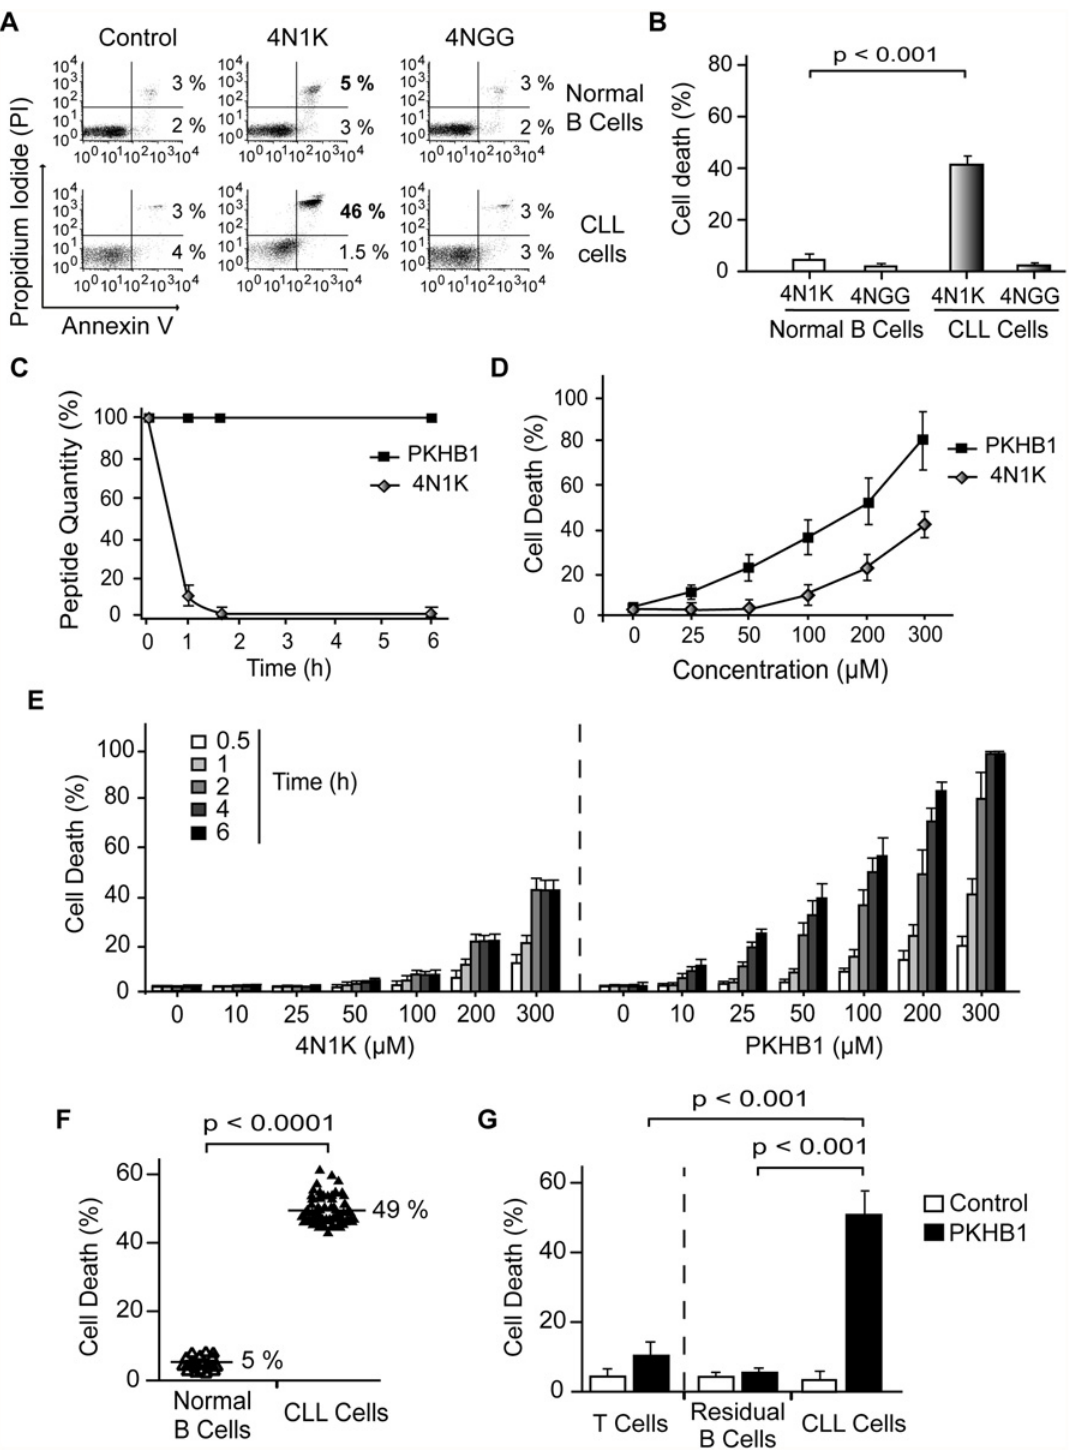
Fig 1. PKHB1 selectively induces cell death in leukemic B cells, including those from patients with dysfunctional TP53 . (A) Cell viability measured by Annexin-V and PI staining in normal or CLL B lymphocytes treated with 4N1K (300 μ M, 2 h) or the negative control peptide 4NGG (300 μ M, 2 h). The percentages refer to Annexin-V-positive or Annexin-V-positive/PI-positive staining. (B) B cells from healthy donors ( n = 8) and CLL patients ( n = 20) were treated and analyzed as in (A) and graphed. The panel of patients used here included an equal number of CLL patients with Binet Stage A and Binet Stage B/ C. Cell death refers to Annexin-V-positive/PI-positive labeling. (C) The proteolytic stabilities of 4N1K and PKHB1 were evaluated in human serum at the